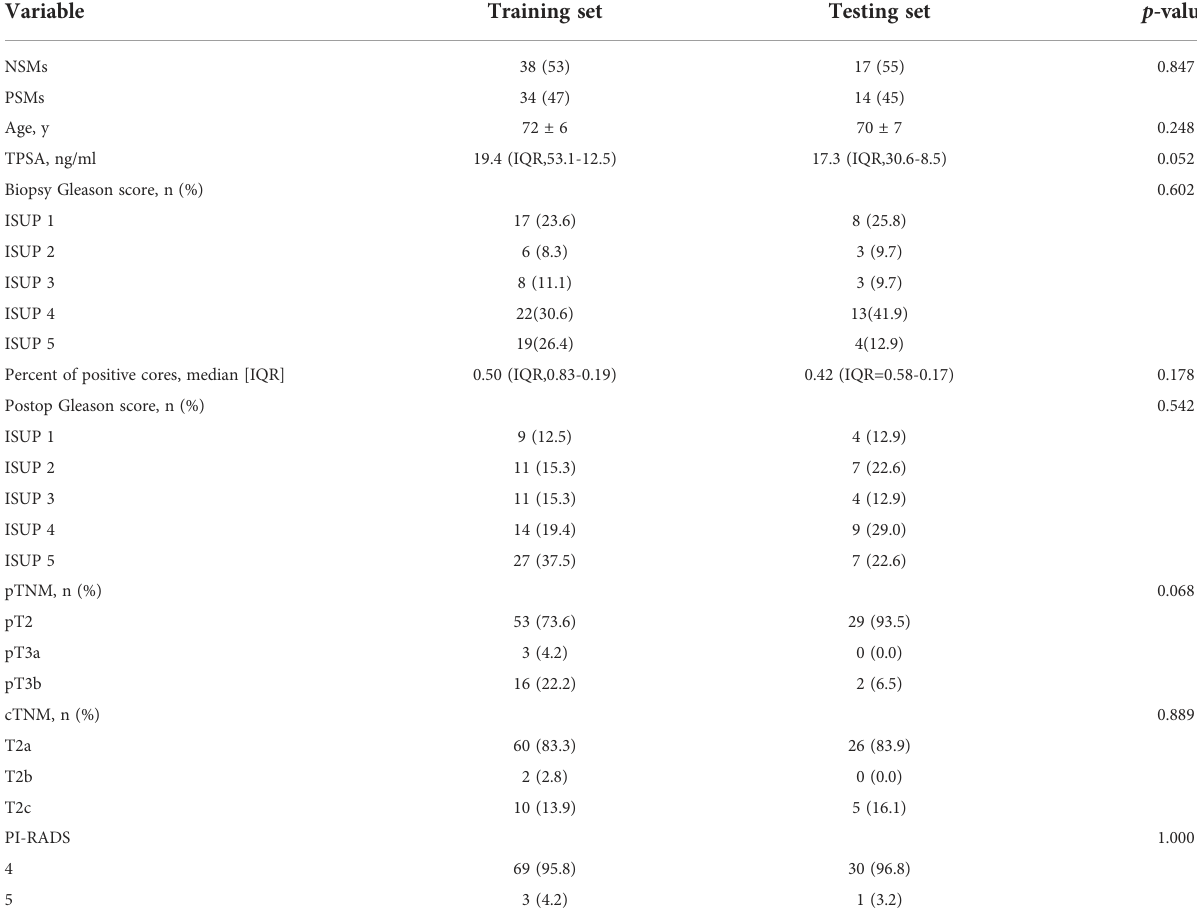
TABLE 4 Clinical characteristics of the training and testing sets for MRI combined with clinical parameters nomogram predicting PSMs. Variable Training set Testing